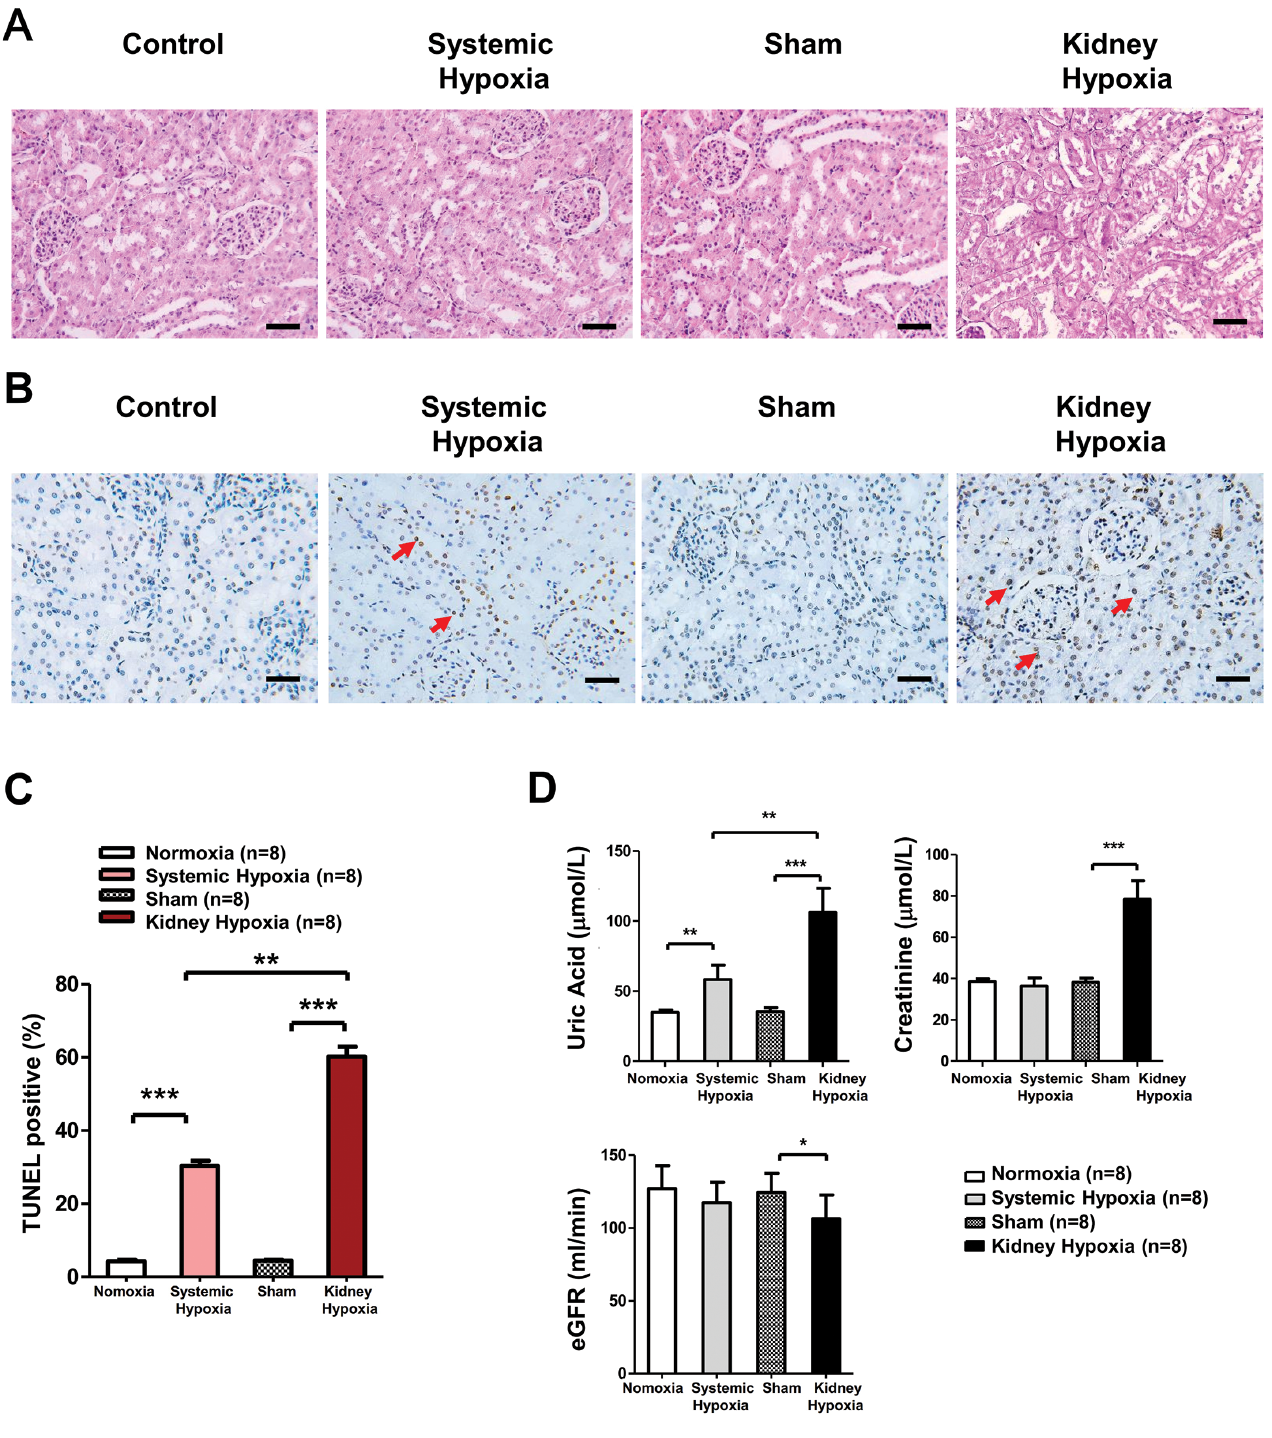
Figure 2. Systemic hypoxia and local kidney hypoxia induced rat kidney lesion. (A) Representative kidney PAS staining of normoxia (n = 8), systemic hypoxia (n = 8), sham (n = 8) and local kidney hypoxia (n = 8) groups. (B) Representative kidney TUNEL staining. (C) TUNEL positive cell quantification in the kidney. The numbers of positive TUNEL stained cells were counted in eight high-power fields. Scale bar = 50 μ m. The red arrows indicate typical apoptotic cells. (D) Measurement of rat serum UA, Cr, eGFR levels (n = 8). Data are shown as mean ± SD. * P < 0.05; ** P < 0.01; *** P <